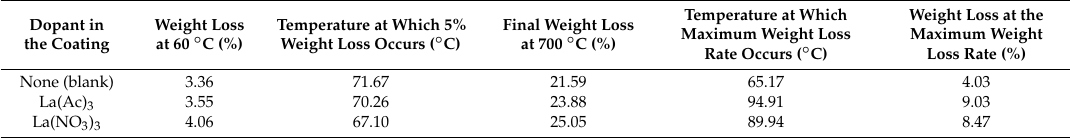
Table 7. Additional data concerning TGAs of some of the samples